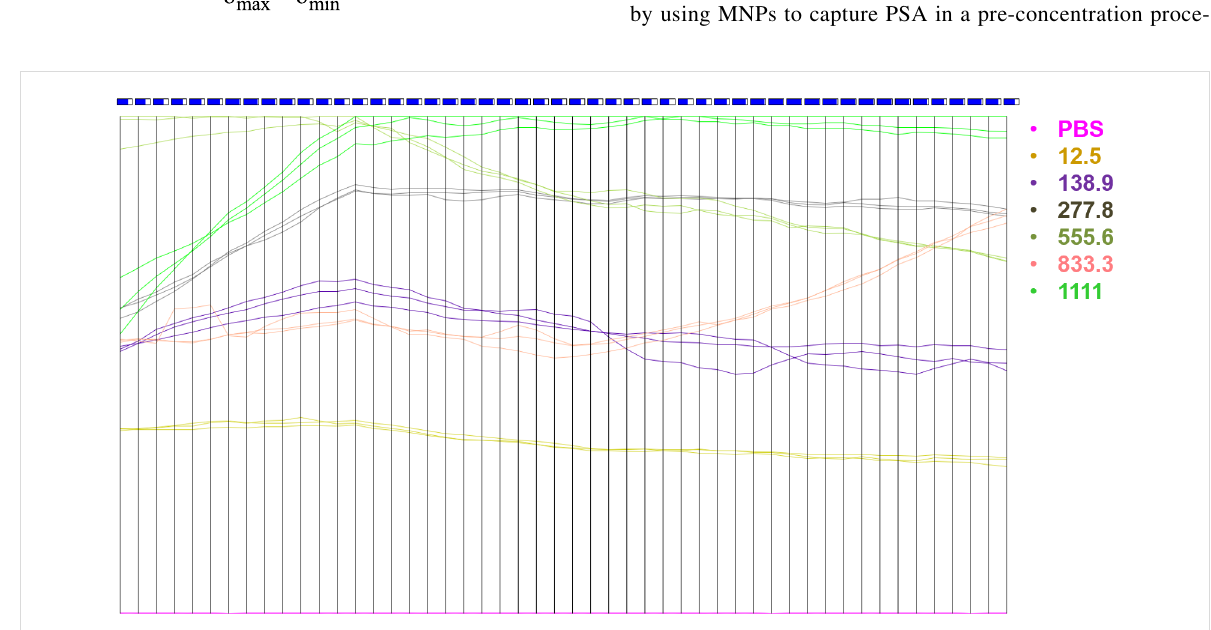
Figure 4: Parallel coordinates plot for PSA concentrations from 12.5 to 1111 fg·mL − 1 after the feature-selection procedure. The x -axis represents time values, while the y -axis represents Euclidean distances related to the current.